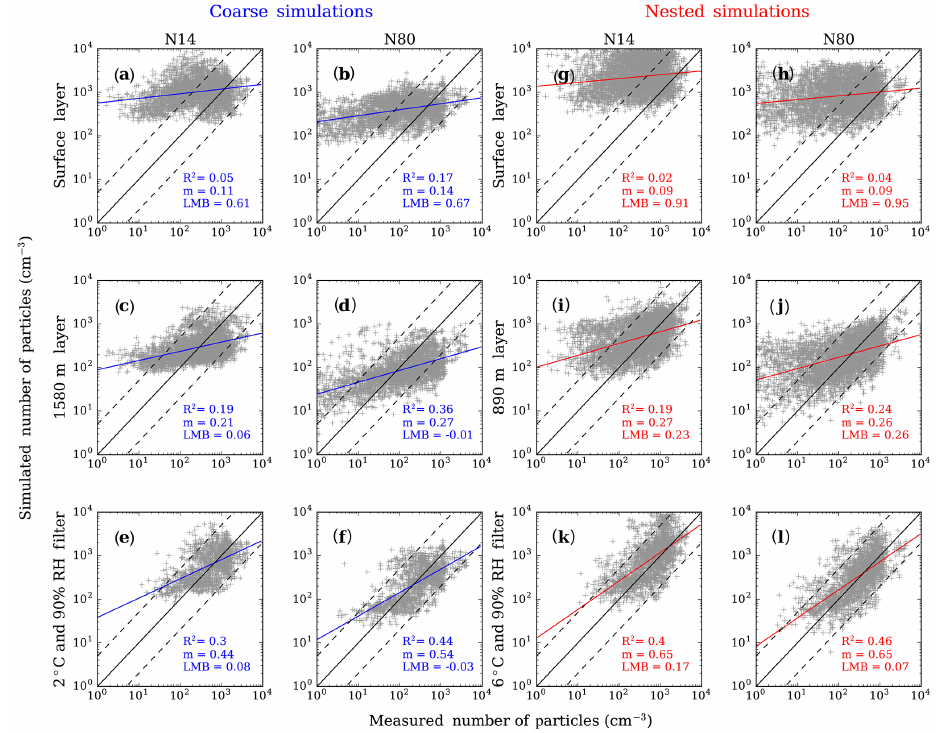
Figure 3. One-to-one plots of measured and simulated N14 and N80 (the total number of particles with particle diameter, D p , > 14nm and > 80nm, respectively) for the nested simulations (0.5 ◦ × 0.667 ◦ , g – l ) and coarse simulations (4 ◦ × 5 ◦ , a – f ). Statistics are colored red for nested simulations and blue for coarse simulations. Panels (a) , (b) , (g) , and (h) represent the model surface layer, panels (c) , (d) , (i) and (j) represent model level corresponding to the actual height of Whistler Mountain peak (890m layer for nested and 1580m for coarse), and panels (e) , (f) , (k) , and (l) are for the filtered combination. For the filtered combination, surface layer in the nested (coarse) simulation is selected when measured temperature exceeds 6 ◦ C (2 ◦ C), 890m (1580m) layer is selected otherwise; points with > 90% relative humidity are removed to reduce in-cloud sampling. The red and blue lines indicate the regression line, solid black line indicates the ideal 1:1 line, and the dashed black lines indicate the 1:5 and 5:1